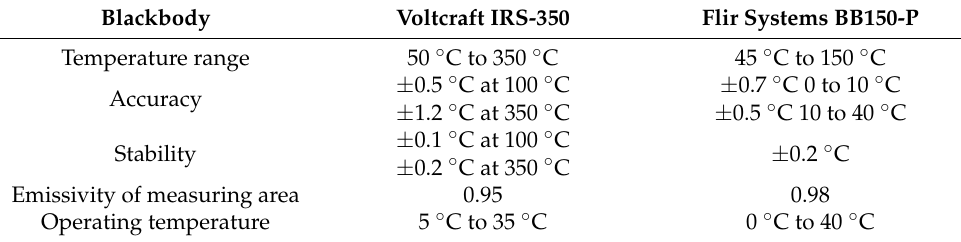
Table 4. Comparison of blackbodies used for imaging and analysis.